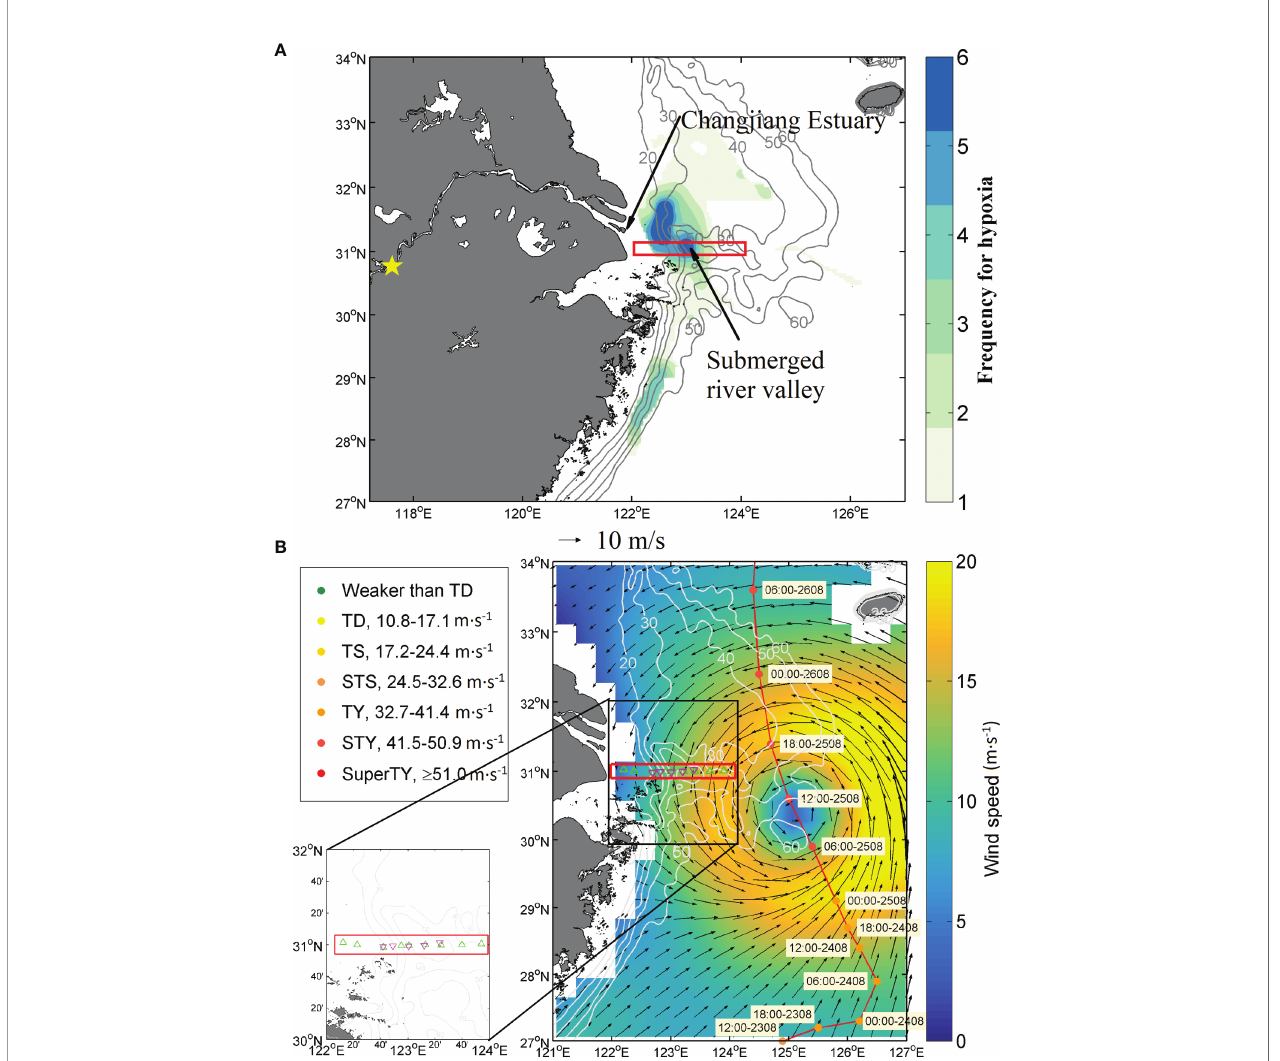
FIGURE 1 | (A) The occurrence frequency for hypoxia off the Changjiang Estuary retrieved from 20 ship-borne surveys from 1988 to 2015 based on 3.0 mg·L − 1 contours of dissolved oxygen (DO) concentration. Cruise information and hypoxia extents can be referred to Zhou et al. (2020). The isobaths are shown by gray contours with 10-m intervals from 20 to 60 m. The location of “ Datong hydrologic station ” is indicated by a yellow pentagram. (B) The wind fi eld vectors over the ECS at 12:00, August 25, 2020 were derived from the cross-calibrated multi-platform (CCMP) ocean vector wind analysis product and are denoted by black vectors where the color indicates speed. The typhoon track (red line) was derived from the western north Paci fi c Tropical Cyclone database created by the China Meteorological Administration (Ying et al., 2014; Lu et al., 2021). Typhoon strength is classi fi ed by the maximum wind speed near the center of the circulation denoted by dots in different colors with the strength marked every 6 h (format: time – date). TD, tropical depression; TS, tropical storm; STS, severe tropical storm; TY, typhoon; STY, severe typhoon; SuperTY, super typhoon. The sampling stations before and after the typhoon passage are denoted by green upward-pointing triangles and purple downward-pointing triangles, respectively. The red rectangle highlights the transect analyzed in this study. The isobaths are shown using white contours at 10-m intervals from 20 to 60 m. A zoomed-in map appears below the